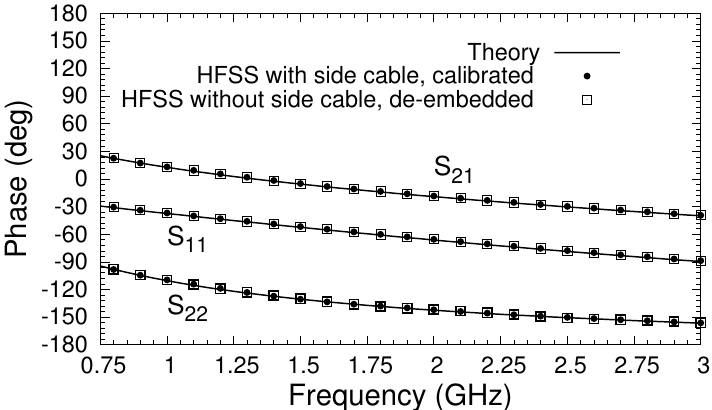
Figure 7. Phases of the S-parameters of the triaxial system after